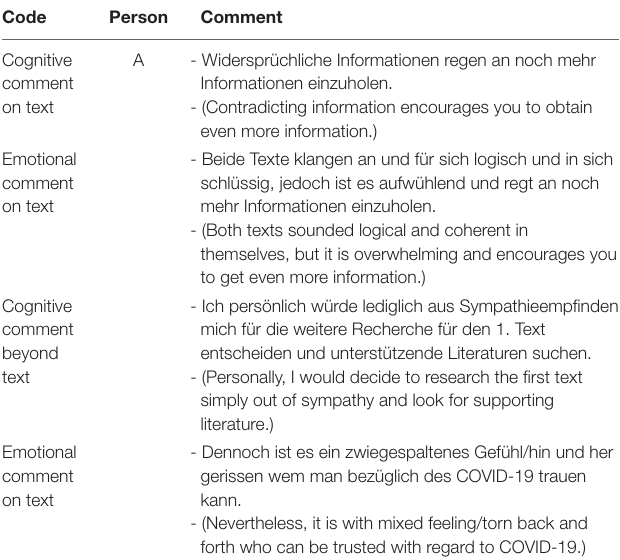
TABLE 1 | Example of an individual reasoning behavior (translation in